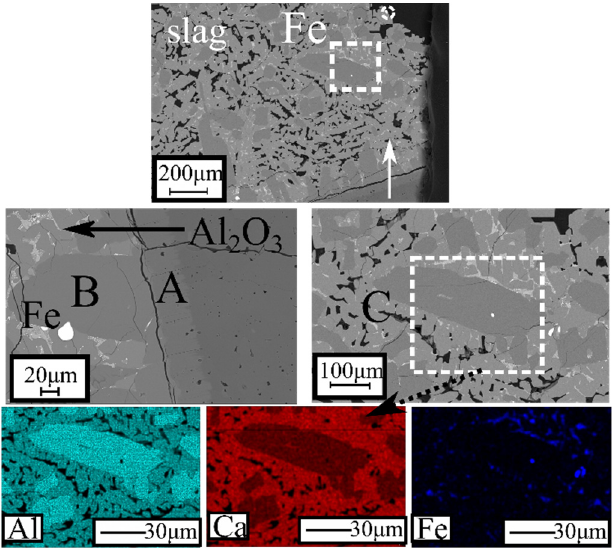
Figure 15. Backscattered electron images and X-ray mapping analysis of S-A-RB slag.